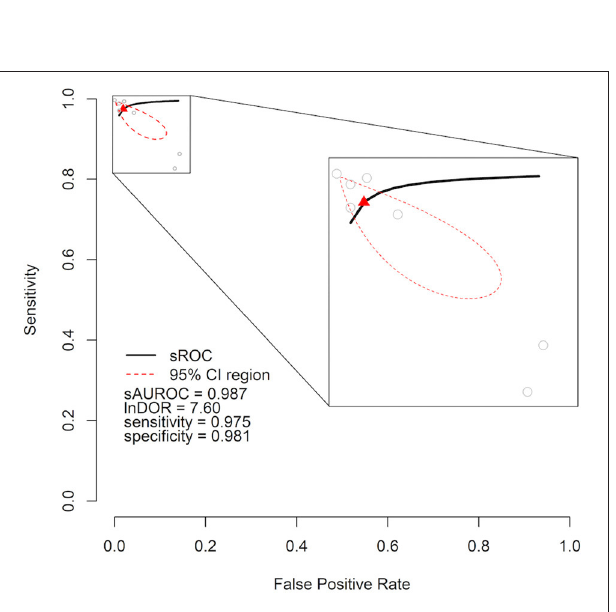
FIGURE 3 | Cumulative summary receiver operating characteristic curve (sROC) of an artificial intelligence–processed ECG approach to detect heart failure. Individual studies are shown as gray circles. Summary point is shown as red triangle. The area of interest is magnified on the right side. lnDOR denotes diagnostic odds ratio after natural logarithmic transformation, sAUROC denotes area under the sROC curve; CI, confidence